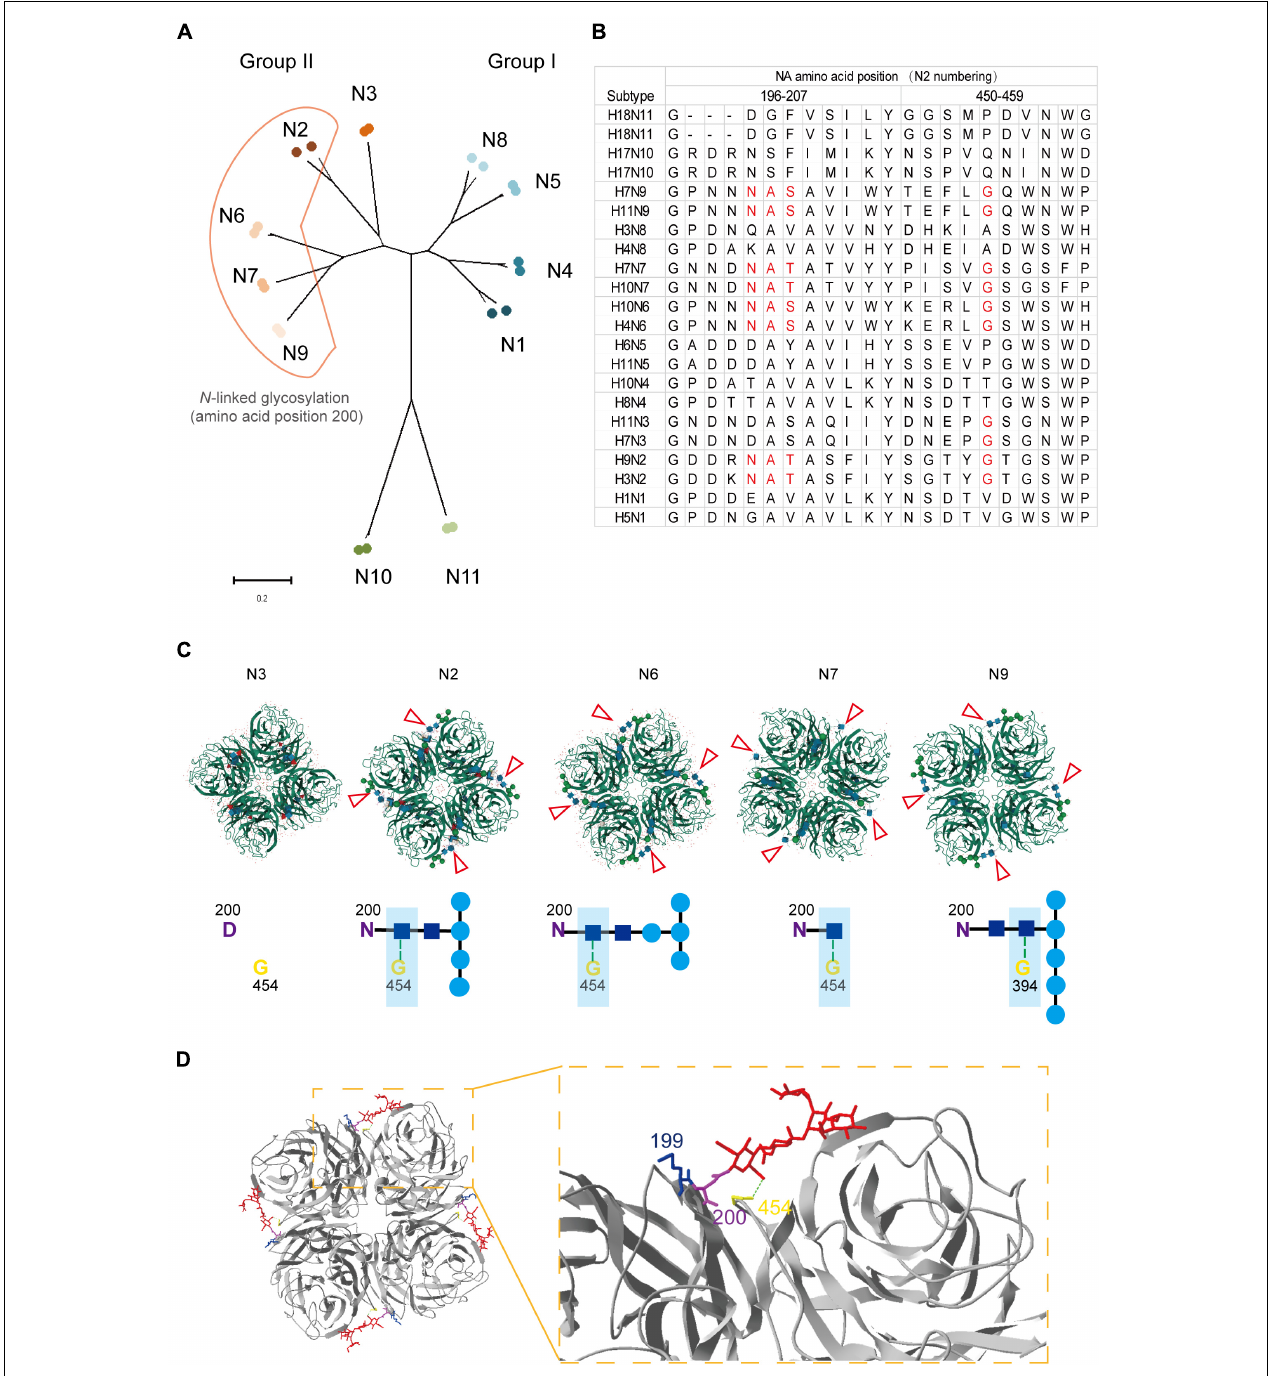
FIGURE 5 | Structural and alignment analysis of residue 199 in NAs. (A) The distribution of N -linked glycosylation at amino acid position 200 in NA subtypes was shown in phylogenetic tree. (B) NA amino acid sequences of 22 strains belong to 11 subtypes was analyzed by alignment with MEGA X. The amino acids from position 196 to 207 and 450 to 459 were shown. Amino acids involved in forming the position 200 N -linked glycosylation site and residue 454 were marked in red. (C) Locations of different N -linked glycosylation modification at position 200 in group II NAs (PDB: 4HZV, 1NN2, 4QN6, 4QN3, and 3NN9) were analyzed online with MoI viewer in RCSB PDB. The glycosylation modification in NA tetramer was shown above and marked with red triangles. The hydrogen bond between N -acetylglucosamine (NAG) and glycine at position 454 or 394 was shown with green dot line below. (D) Status of residue 199 in case of N -linked glycosylation modification at residue 200 was analyzed by Swiss PDB Deep-viewer. The structure of N2 (PDB:4GZX) was used for analysis. The sugar chain was marked in red. Residues 199, 200, and 454 were individually labeled with blue, purple, and yellow. Hydrogen bond between NAG and G454 (or G394) is shown with green dotted